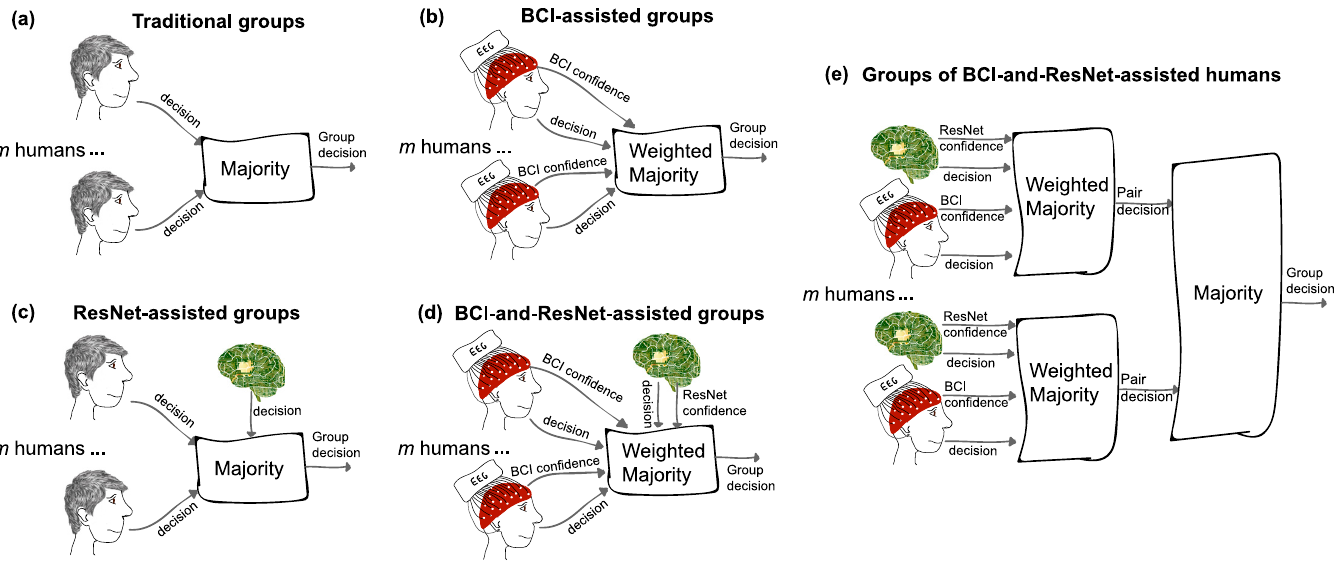
Fig 3. Summary of the different methods for obtaining decisions of groups of size m . (a) Traditional groups of human participants based on standard majority. (b) Groups of human participants weighing individual decisions with the confidence estimated by the BCI. (c) Traditional groups based on standard majority with an additional member being the ResNet. (d) BCI-assisted groups with the ResNet as an additional member, with its degree of confidence. (e) Groups where each participant is assisted by the BCI and paired with the ResNet, and the decisions of these pairs are then integrated using standard majority.